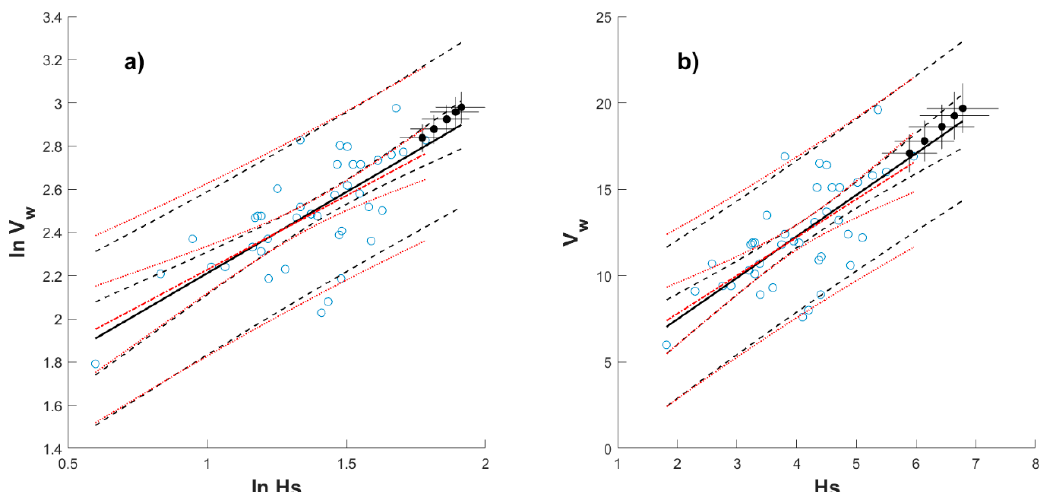
Figure A8. Regression lines and confidence intervals including (solid and dashed lines, respectively) and excluding (dashed–dotted and dotted lines, respectively) T -yr values for November; ( a ) and ( b ) for logarithmic space and linear space, respectively. Filled circles represent T -yr values with embedded perpendicular lines indicating confidence intervals from GEV models.